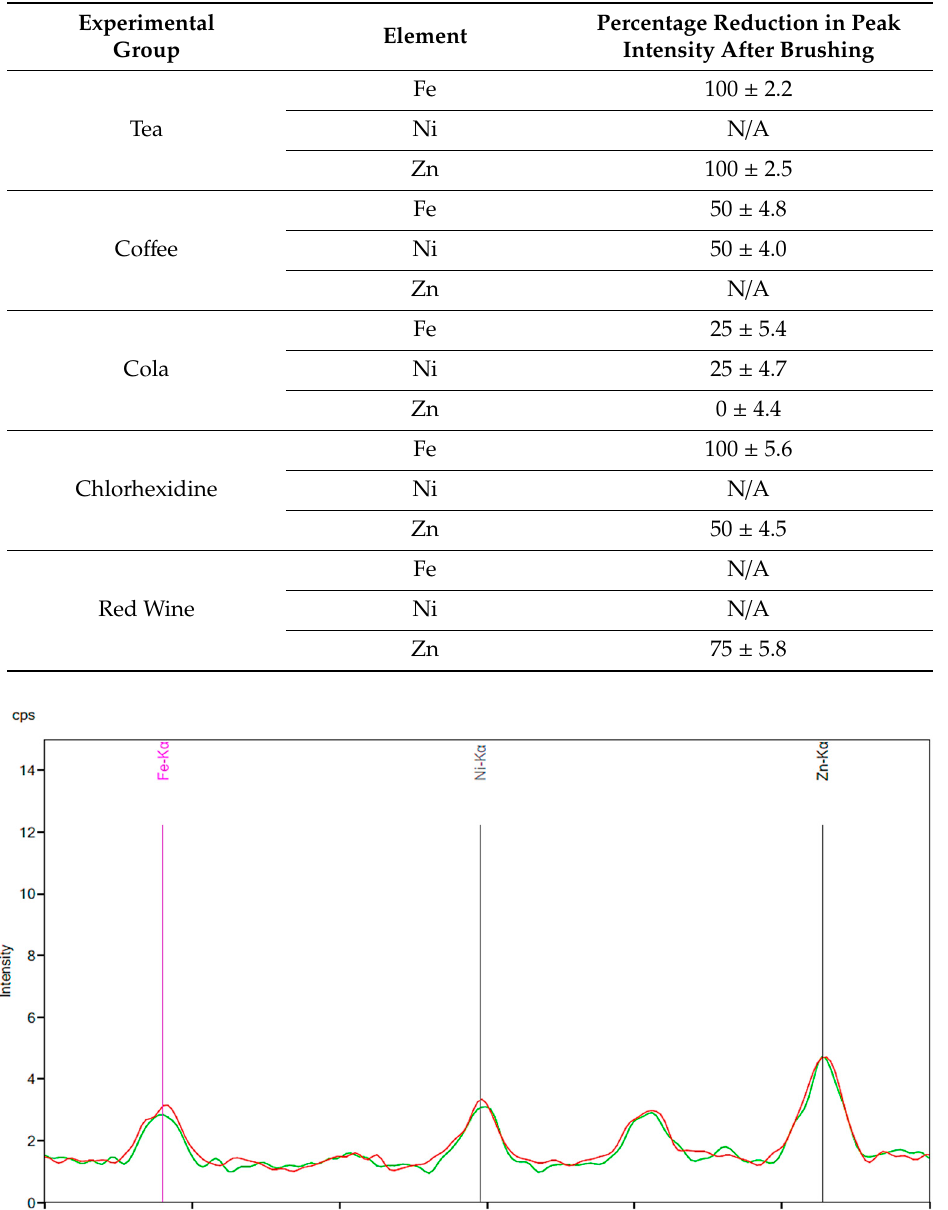
Table 2. Average data collected for each experimental group for the brushing experiments. Percentage reductions in peak intensity following brushing were calculated based on the extent to which the intensity returned to baseline (the quantity before exposure to the liquid) following 30 s of brushing. A value of N / A indicates that there was no substantial increase in peak intensity following exposure to the liquid, therefore a reduction in intensity following brushing is non-applicable.